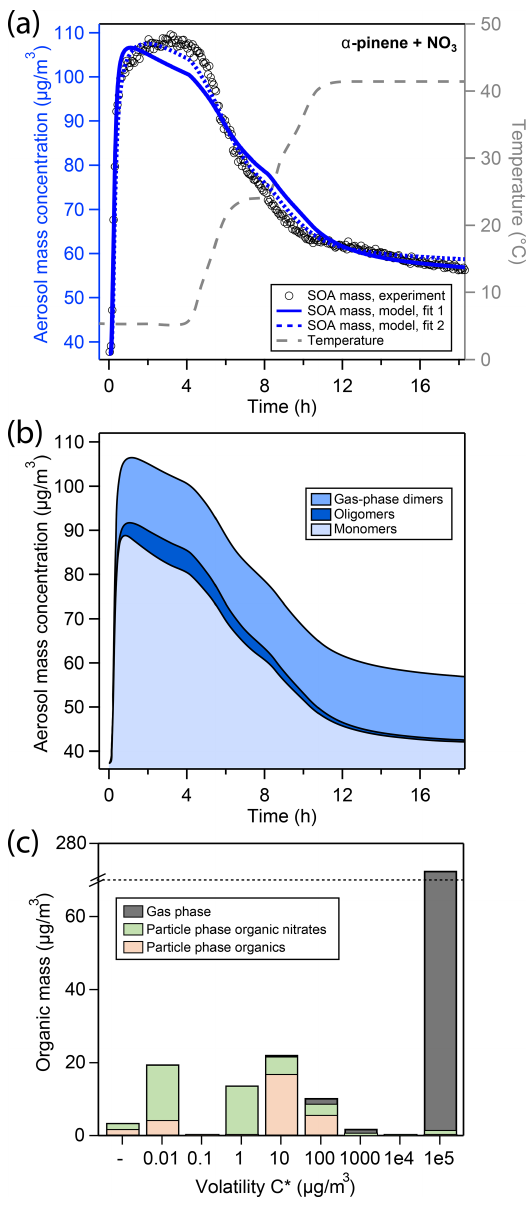
Figure 3. (a) Comparison of experimental and modeling results of aerosol mass for oxidation of α -pinene with NO 3 . Open black mark- ers are experimental aerosol masses obtained using an SMPS. The blue solid line represents the best-fit model result, the blue dotted line represents an alternative model fit, and the grey dashed line corresponds to the experimental temperature profile. (b) Analysis of the oligomerization state of particle-phase products in the model according to fit 1. (c) Analysis of the occupation of volatility bins of all products according to fit 1 and during peak SOA mass. Shadings in the bar plot denote where molecules of a certain volatility bin reside: gas phase (grey) or particle phase (colored). Products in the particle phase are further distinguished as organic nitrates (green) and non-nitrated organics